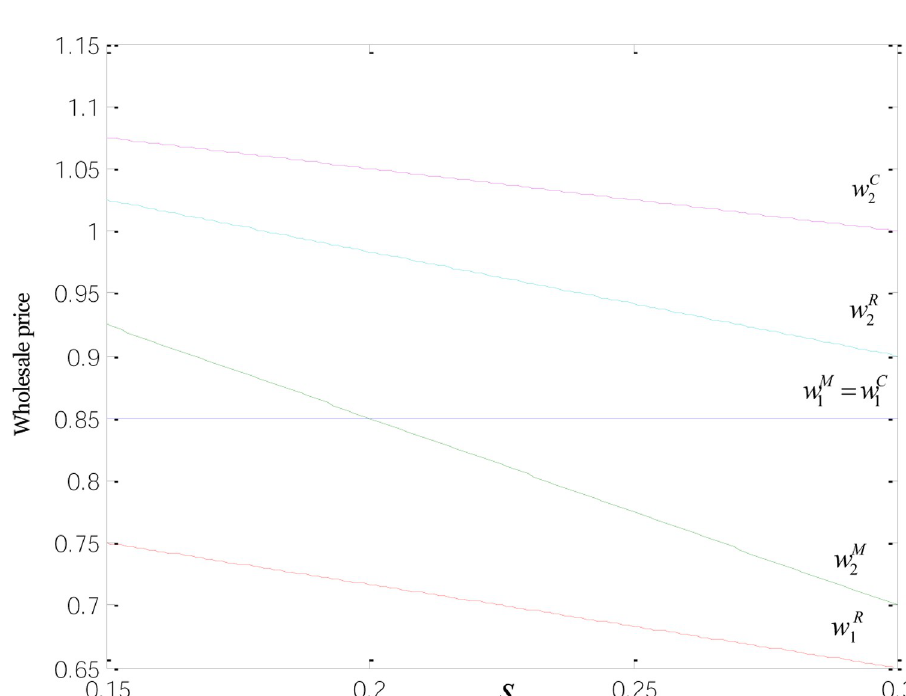
Fig 4. Relationships between the wholesale price and low-carbon subsidies.